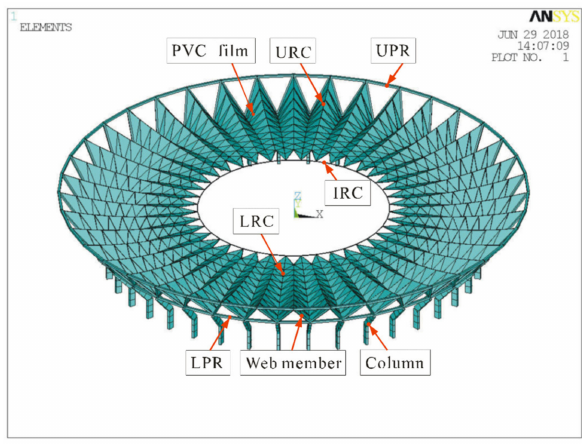
Figure 7. Finite element model of